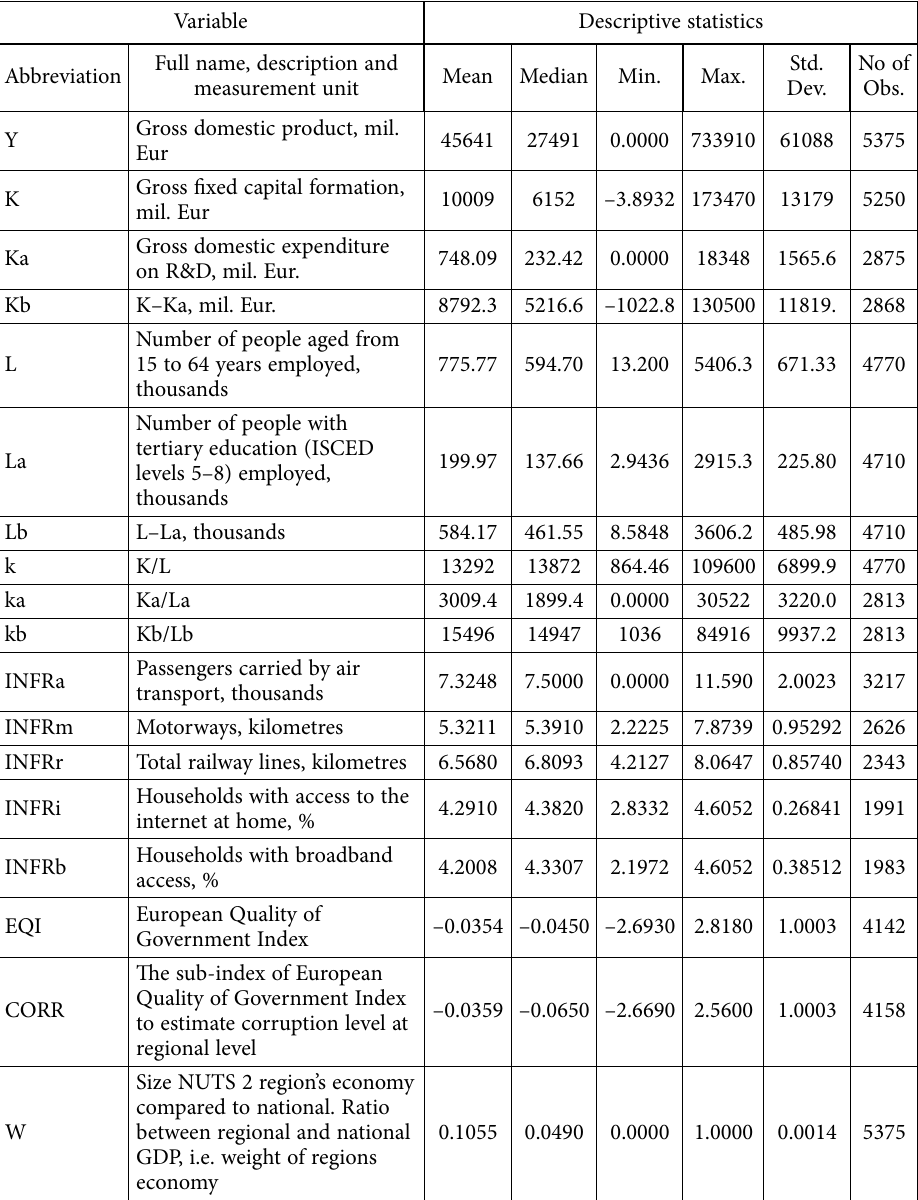
Table 2. Summary statistics of the variables